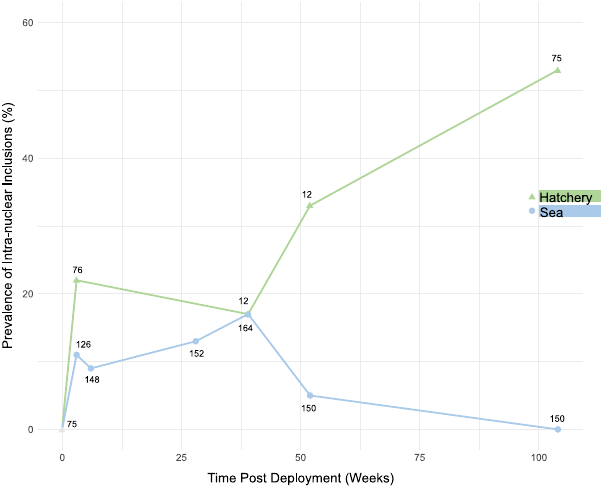
Figure 2. Prevalence of intranuclear inclusions in sea-based and hatchery lobsters over 104 weeks. Proportion of surviving lobsters displaying histopathological signs of viral infection. Green triangles: hatchery-based animals. Blue circles: sea-based animals. Sample size indicated at each